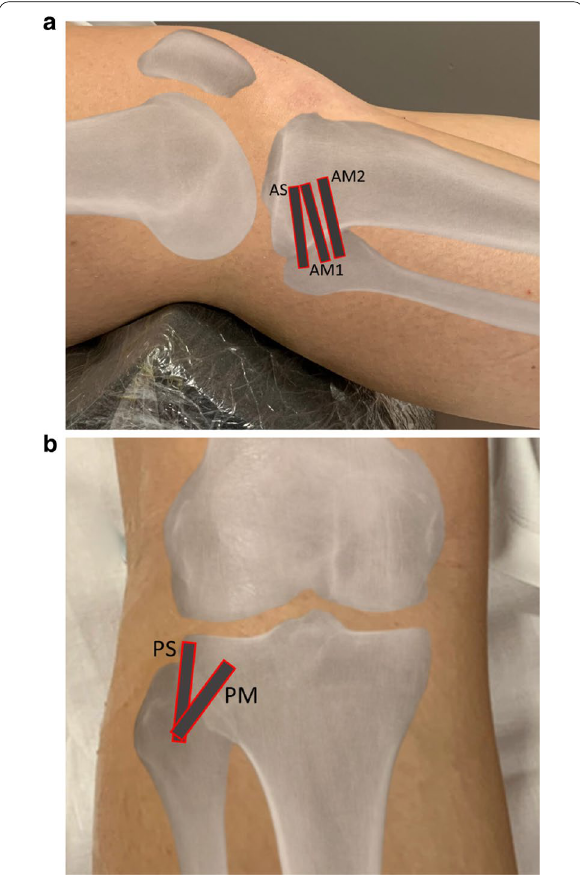
Fig. 1 Probe and patient positions for the assessment of anterior PTF ligaments. a AS: superior bundle, AM1: upper middle bundle; AM2: lower middle bundle. b PS: superior bundle; PM: middle bundle